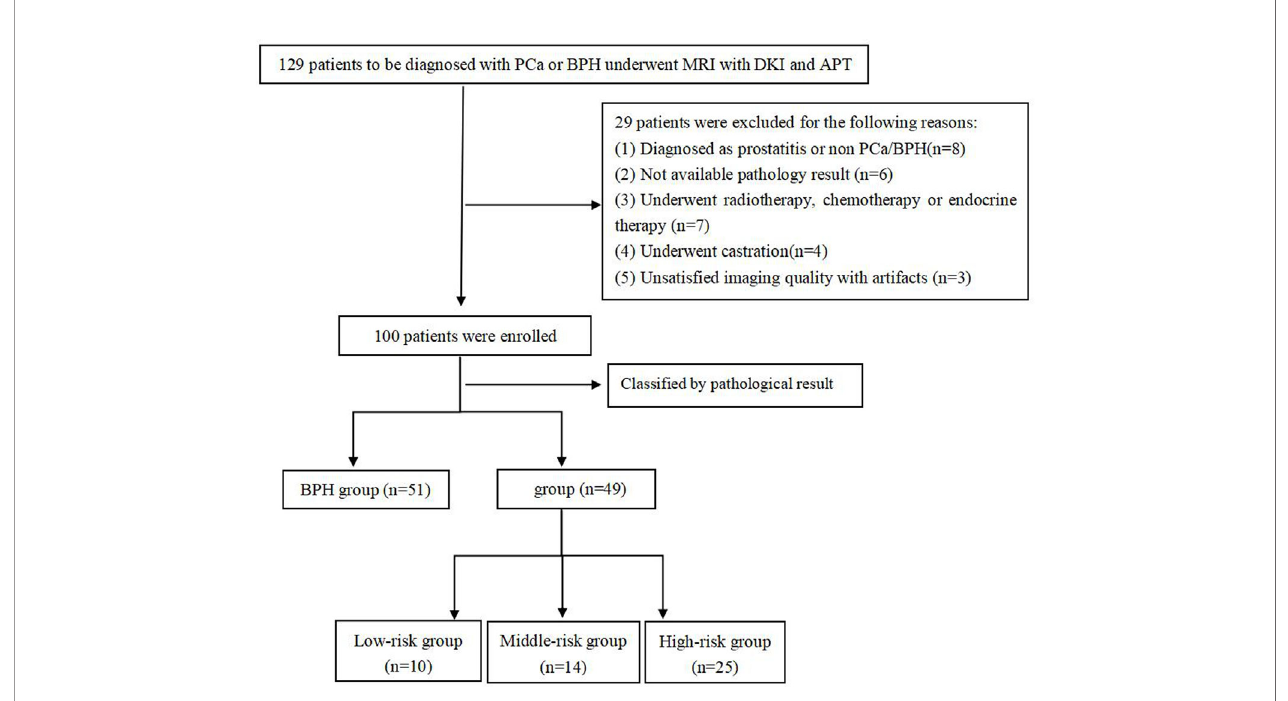
FIGURE 1 | Flowchart of the patient selection